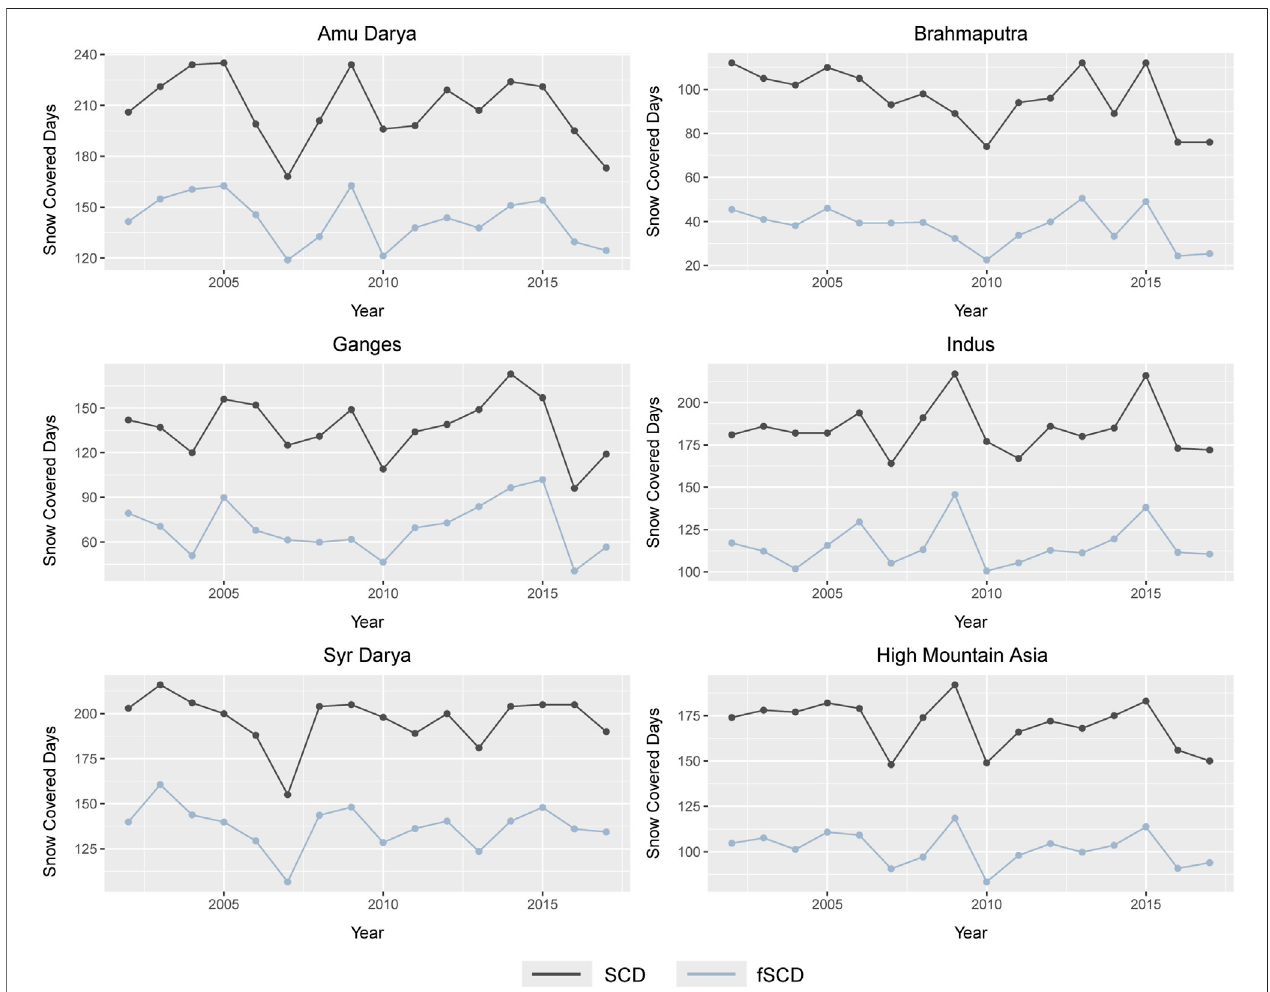
FIGURE 4 | Snow covered days and fractional snow-covered days per basin from 2002 to 2017. Note the different y -axis for each basin or study plot.